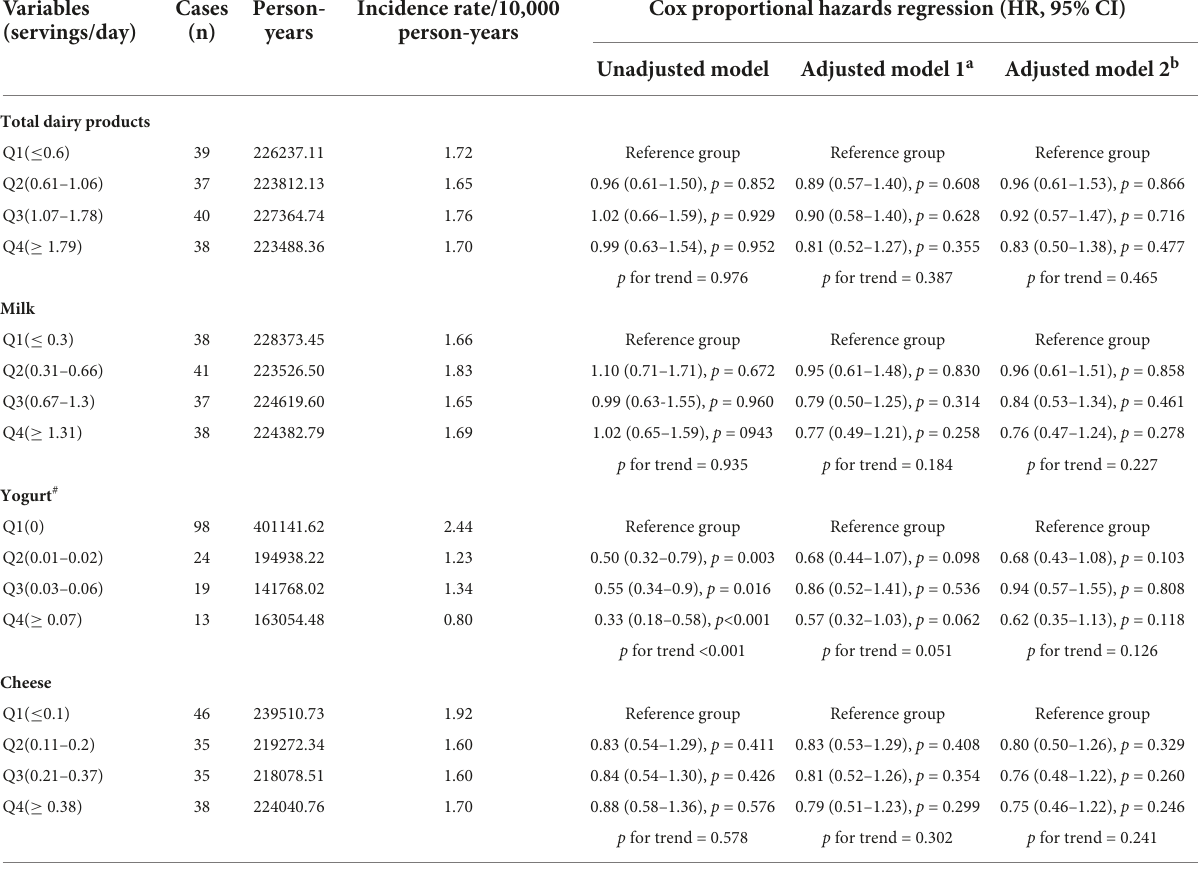
TABLE 2 Association between dairy consumption and esophagus cancer risk in the PLCO trial. Variables